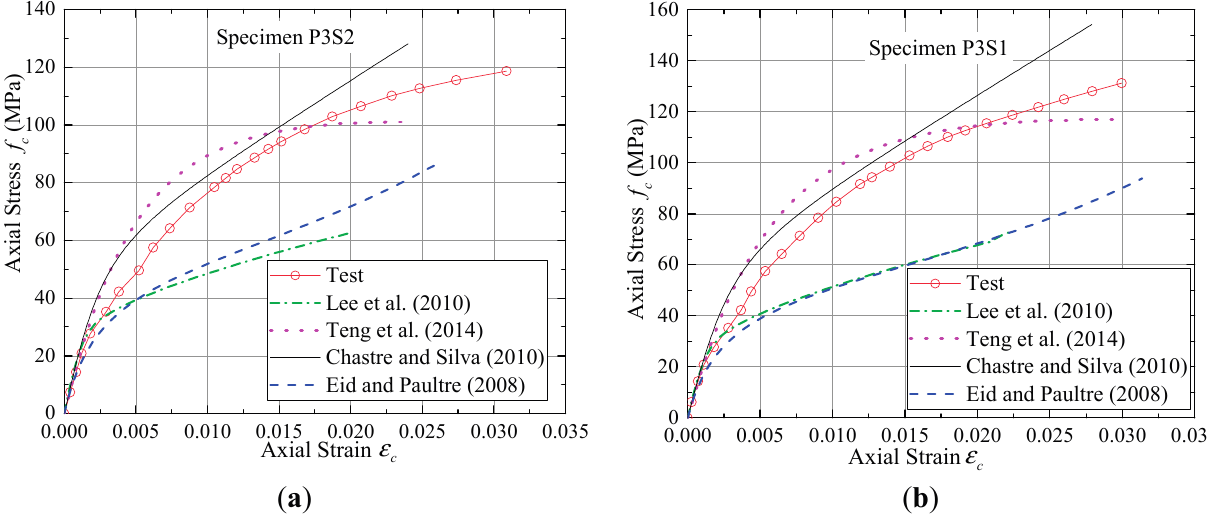
Figure 12. Performance of models for GFRP–SR confined concrete with a ( a ) low ( b ) medium level of steel